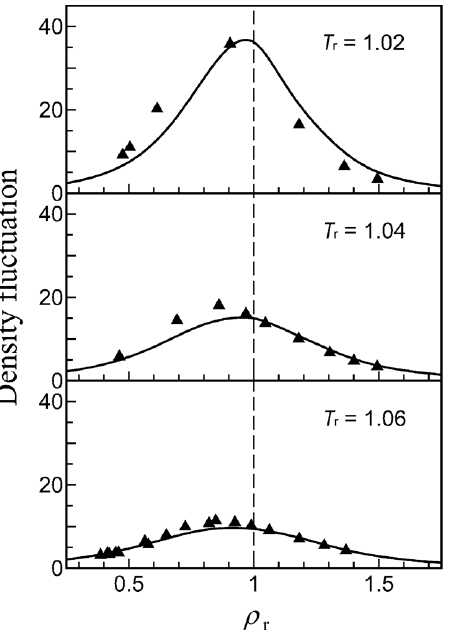
Figure 1. Comparison of density fluctuation of SCW obtained from scattering experiments (triangles) with calculated ones from the equation of state of Wagner et al. [26] (solid curves). This figure is reprinted with permission from J. Supercritical Fluids 2004 , 30 , 249. Copyright 2004 Elsevier.